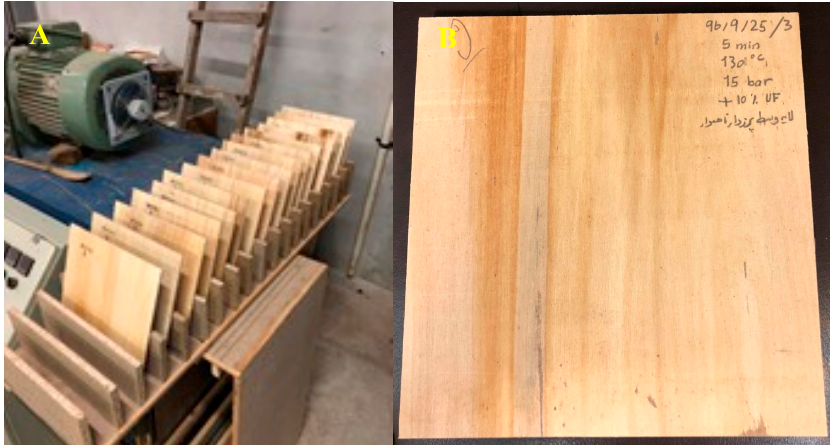
Figure 1. Panels produced and trimmed, ready to be cut to size for each test according to the relevant standard ( A ); front surface of a trimmed plywood panel ( B ).